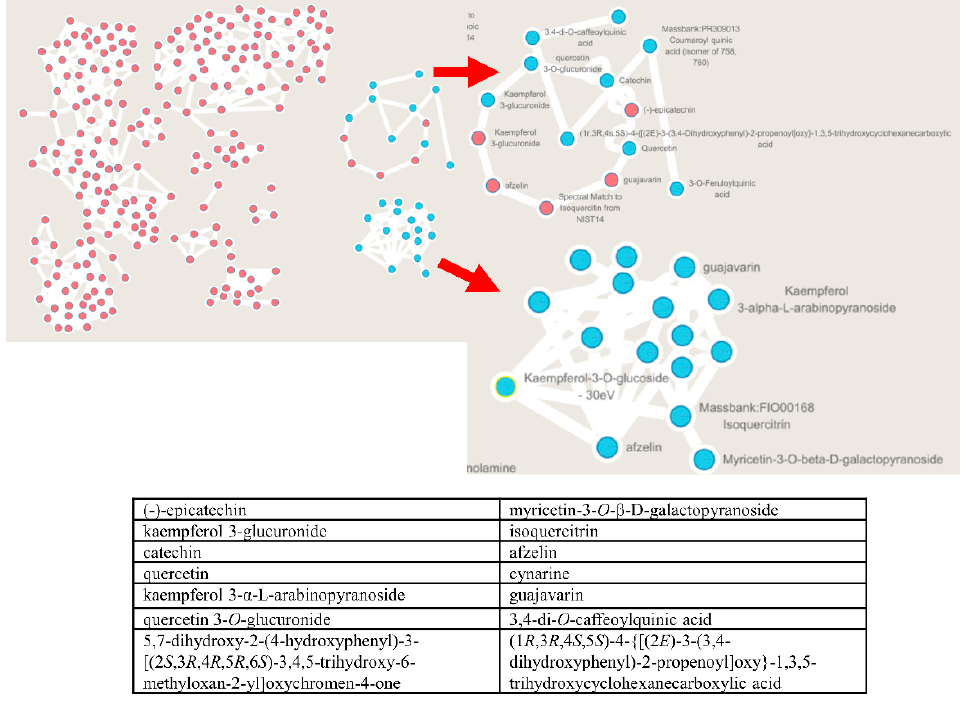
Figure 8. The molecular networking for CPF (flavonoids fraction from C. paliurus leaves) using GNPS (Global Natural Product Social Molecular Networking) analysis.